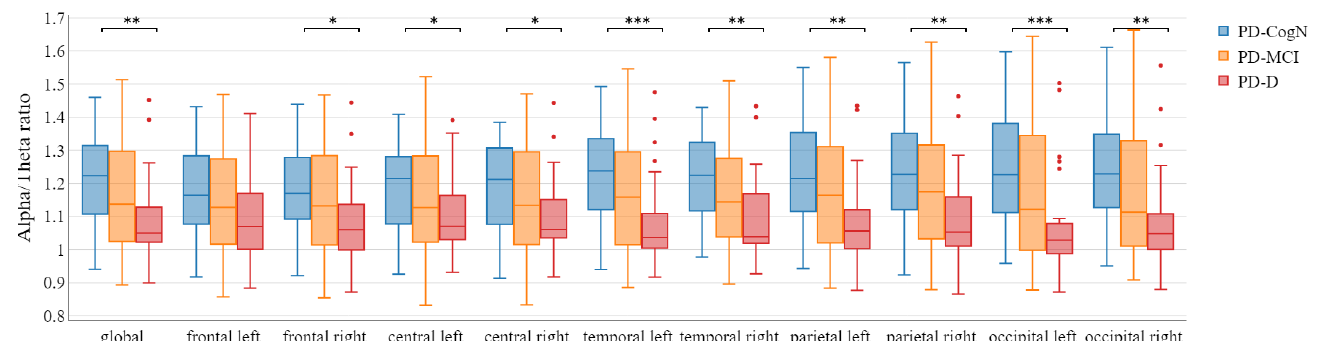
Figure 4. Alpha/theta ratio in the different areas between patient’s groups with statistical signifi-